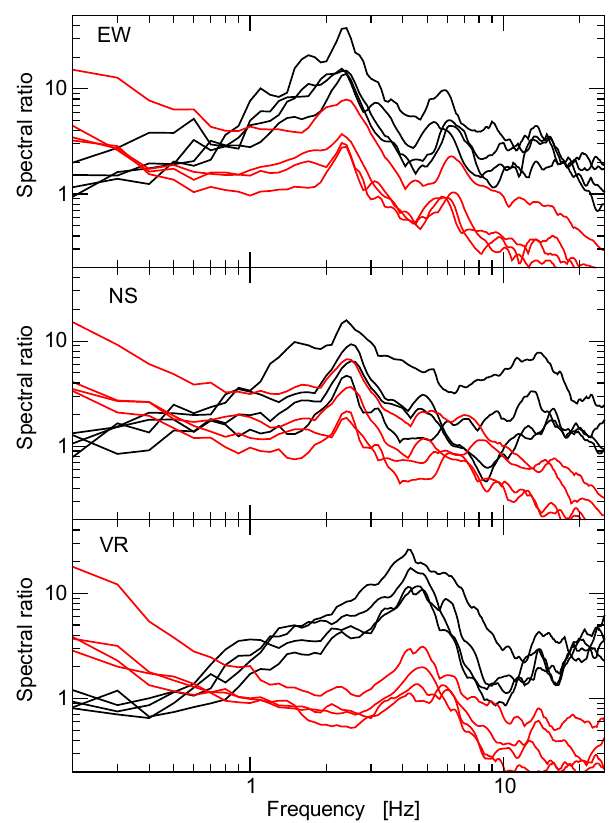
Figure 9. Estimates of site response for station EST calculated as response spectral ratios (RSR) of aftershock records. Each line corresponds to one event. Black lines show the results of RSR relative to station CAL. Red lines show the estimates obtained using response spectra computed using SMSIM as reference. Each frame corresponds to one component, EW, NS, and vertical.